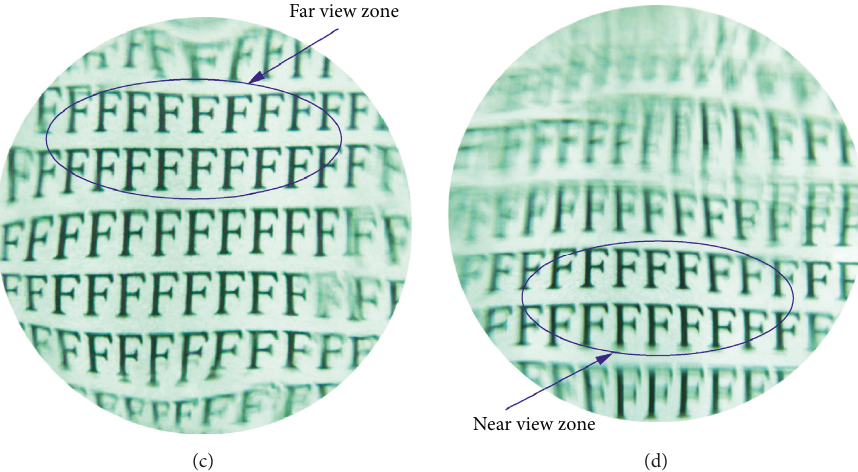
Figure 12: Test images of the F target for different focal lengths. (a) Focused image in the far view region ( f � 250mm). (b) Focused image in the near view region ( f � 200mm). (c) Focused image in the far view region ( f � 250 mm). (d) Focused image in the near view region ( f �